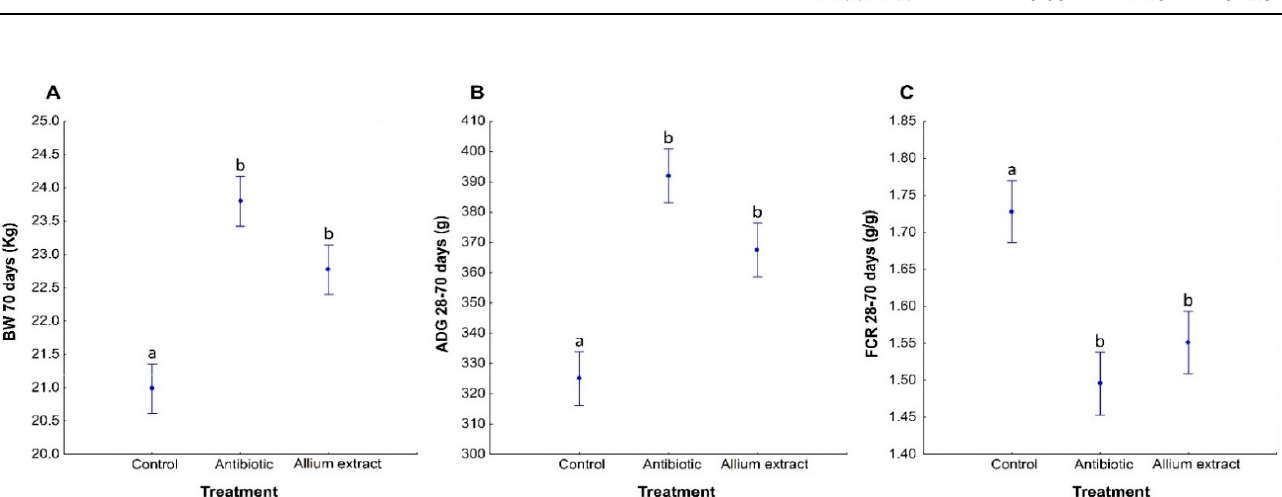
Figure 4. Average ± standard error of the mean of the Body Weight (BW) at 70 days of life ( A ), Average Daily Gain (ADG) ( B ), and Feed Conversion Ratio (FCR) ( C ) from 28 to 70 days of life of weaned piglets fed with control diet or antibiotic or Allium extract supplemented diets. Bars with different letter denote significant differences in treatment (LSD Posthoc test; p < 0.05). Table 4. General Linear Models exploring the effects of treatment as factor, sex, and block as random factors and initial body weight as covariate, in weaned piglets fed with control diet or supplemented with antibiotic or Allium extract. BW refers to body weight, ADG to average daily gain, FCR to feed conversion rate, and ADFI to average daily feed intake. D.f. refers to degree of freedom. The first number is the degree of freedom of the independent variable and the second one for the error term. Significant p -values are shown in bold. Dependent Variable